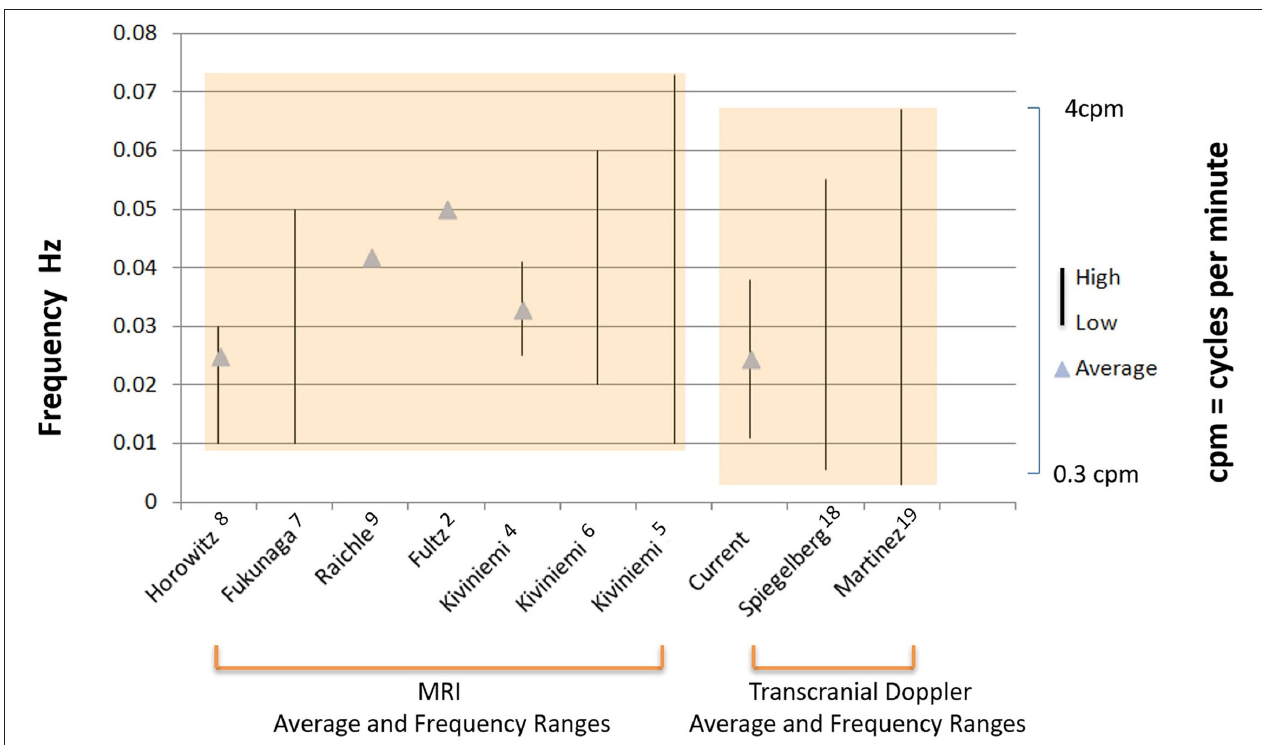
FIGURE 5 | Comparison of MRI and TCD measured frequency values of CBF and CSF oscillations. Illustration of the graphic comparison of the raw numerical data given in Table 2 , for visualization of both the individual studies which reported either mean frequencies (triangles), and, or frequency ranges (solid vertical lines) for MRI slow wave oscillations (left bracket), or B waves recorded by TCD and ICP (right bracket). (note: some studies reported mean frequency values only, indicated by triangles, some studies reported frequency ranges only, indicated by vertical lines, and others reported mean and range values for frequency, indicated by both triangles and vertical lines). The first authors of each of the studies and reference numbers are given in the same order from left to right in which they appear in Table 2 from top to bottom. The values for the label current, refer to results of the frequency analysis for B waves presented in this paper. The overall range of values between the MRI derived data, and the TCD and ICP derived data is also indicated by the shaded boxes, which emphasize the close overlap of these group values to each